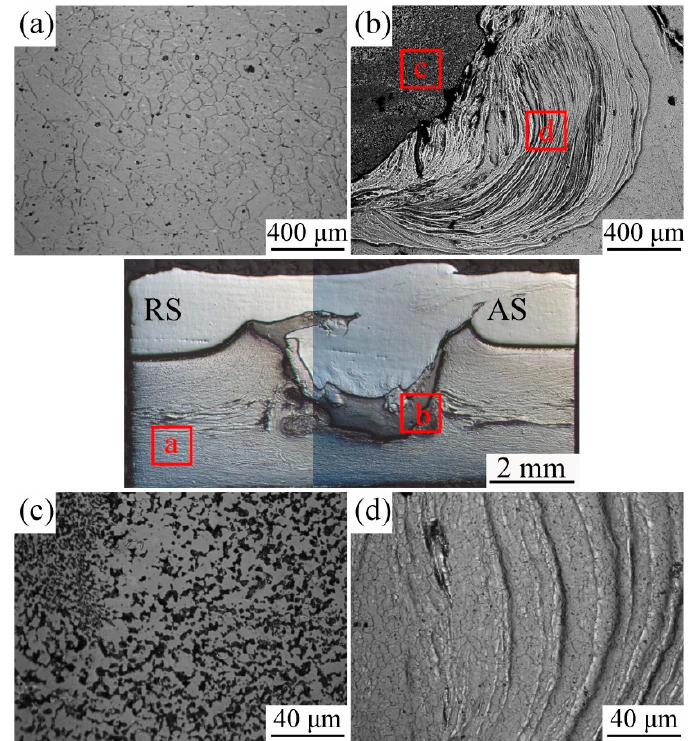
Figure 12. Transverse cross-sections of different areas ( a – d ) in the Al–Mg interface (P7).